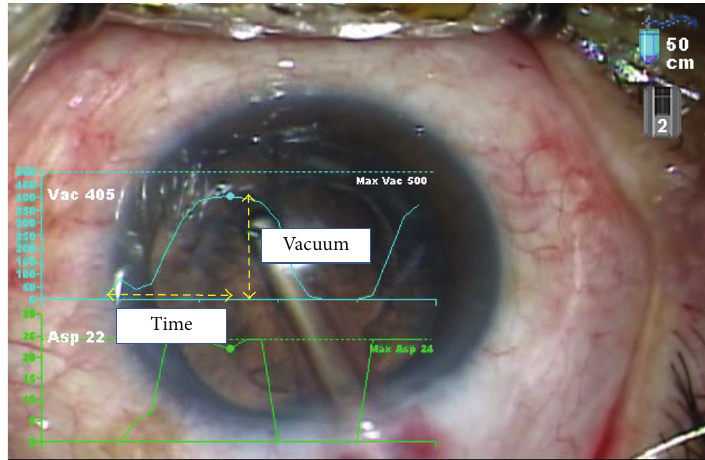
Figure 3: Changes in vacuum level over time during irrigation and aspiration (IA).